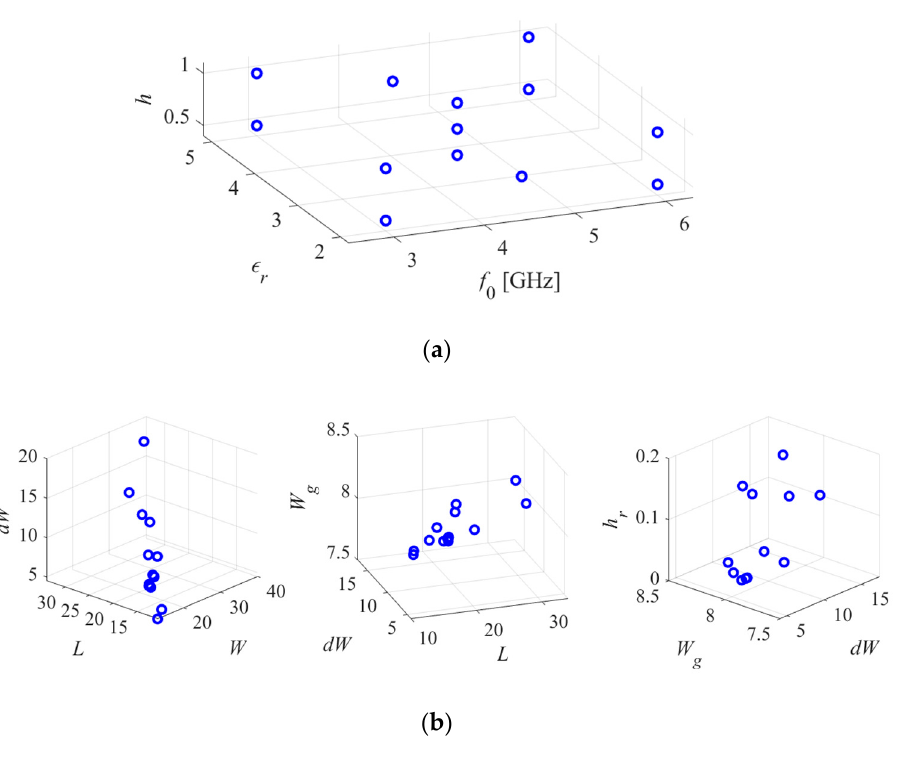
Figure 12. Allocation of the reference designs for the antenna of Figure 11: ( a ) objective space, ( b ) selected three-dimensional projections of the parameter space.